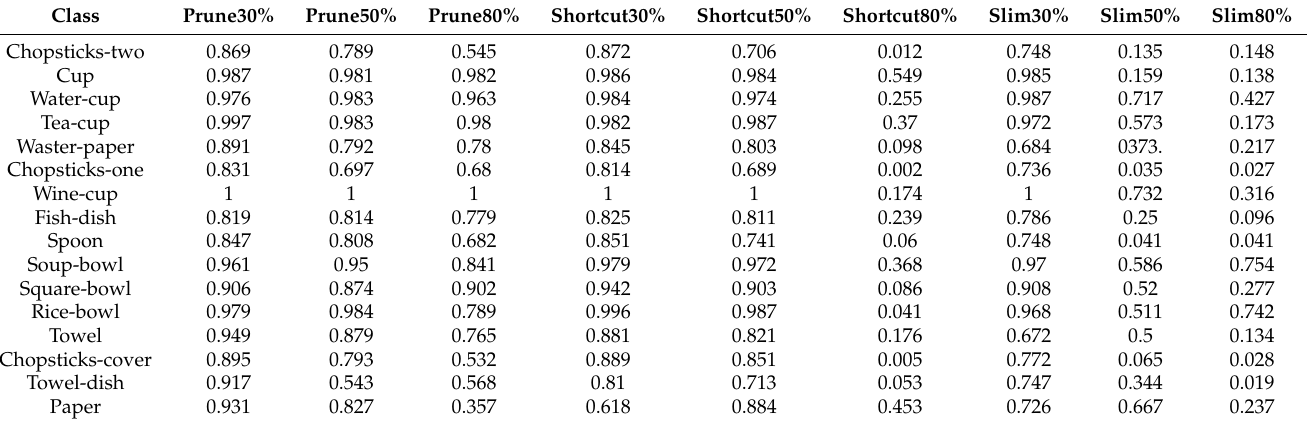
Table 4. Detection accuracy using sparse training Method A on FPGA.